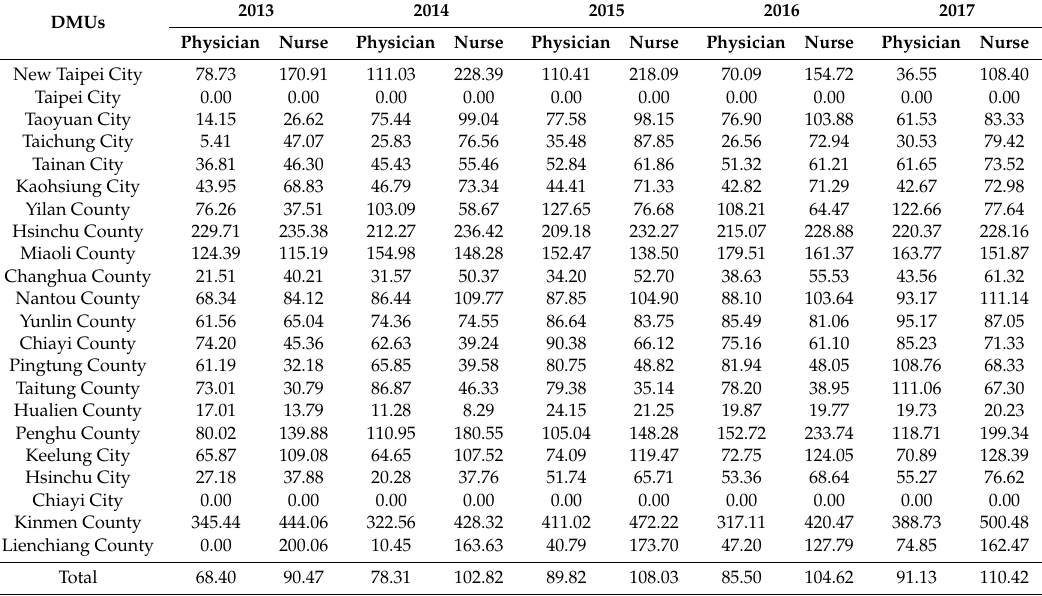
Table A3. The potential adjustment ratio (%) of medical sta ff for each administrative region in Taiwan.